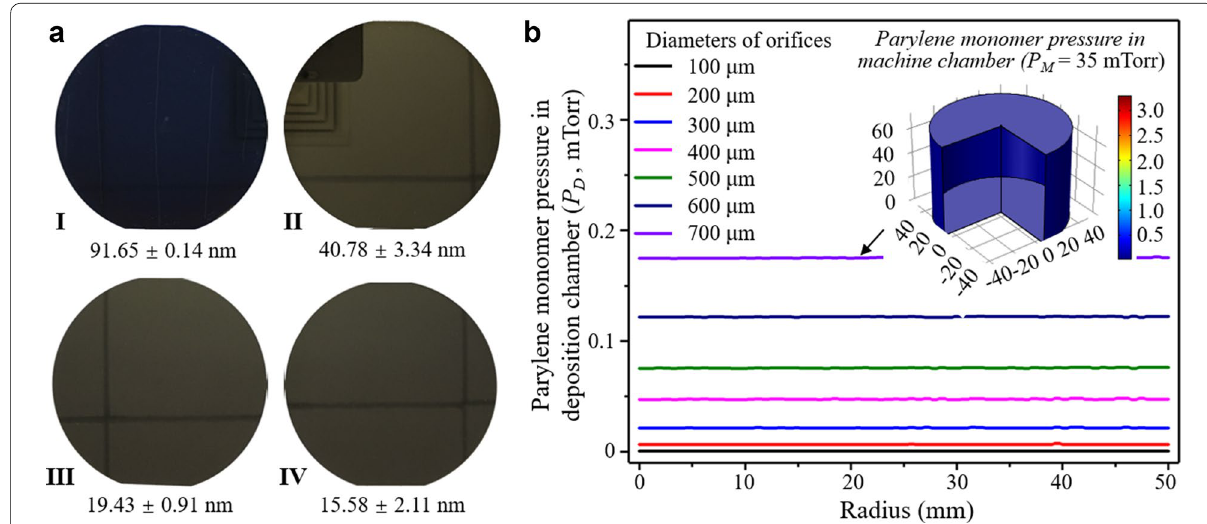
Fig. 4 Uniformity of the present effusion‑based ultra‑thin Parylene deposition. a Photos of the so‑deposited ultra‑thin Parylene films on 4‑inch silicon wafers. The values of thicknesses were shown on bottom of the wafers. The patterns on the wafer II, III, and IV with different colors were the shadows of the ceiling in the clean room and did not actually exist on the wafers. b Numerical result of the monomer pressure distributions in the deposition chambers of different sized orifices. The inset shows a typical monomer pressure distribution inside the deposition